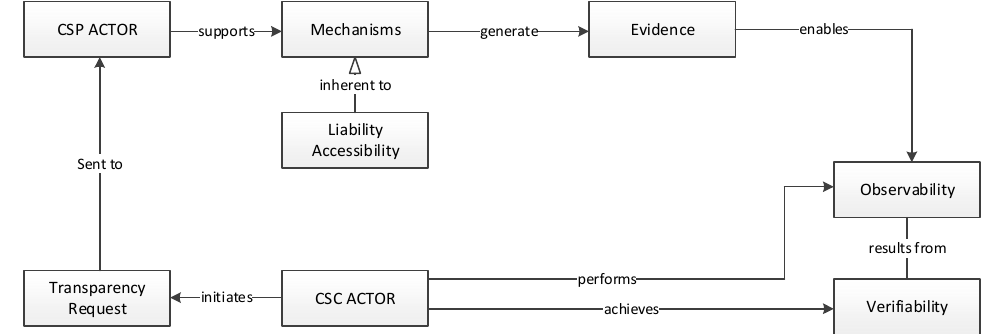
Figure 5. Conceptual Model of Cloud Security Transparency.